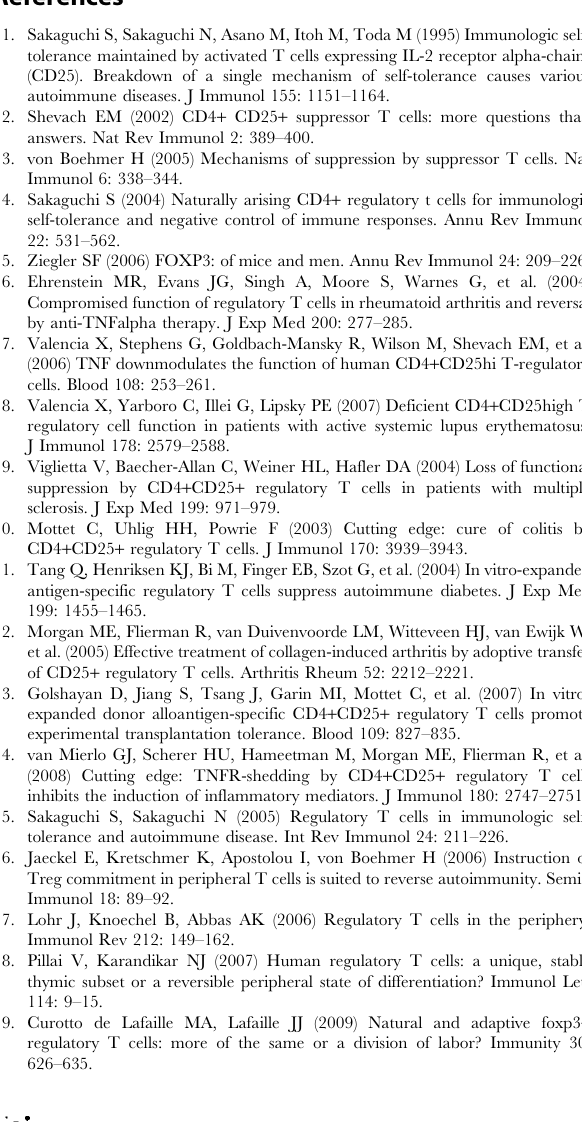
correspond to the p values in iTregs and Teffs, respectively. Red and green boxes indicate unique GO terms for iTregs and Teffs, respectively. Yellow boxes represent GO terms enriched in the gene lists of both, iTregs and Teffs. Figure S4 Network organization of ‘‘FoxO family sig- naling’’ and ‘‘FoxM1 transcription factor network’’ pathways. Each node represents proteins, small molecules or protein complexes participating in the pathway. Nodes marked by black cycles correspond to the transcripts identified by the microarray as to be regulated in developing iTregs (‘‘FoxO family signaling’’) or in developing Teffs (‘‘FoxM1 transcription factor network’’). Figure S5 FoxO and FoxM1 pathways. Expression of the specific transcripts from ‘‘FoxO family signaling’’ and from ‘‘FoxM1 transcription factor network’’ pathways determined by microarray analysis is shown as mean + SD from results of three